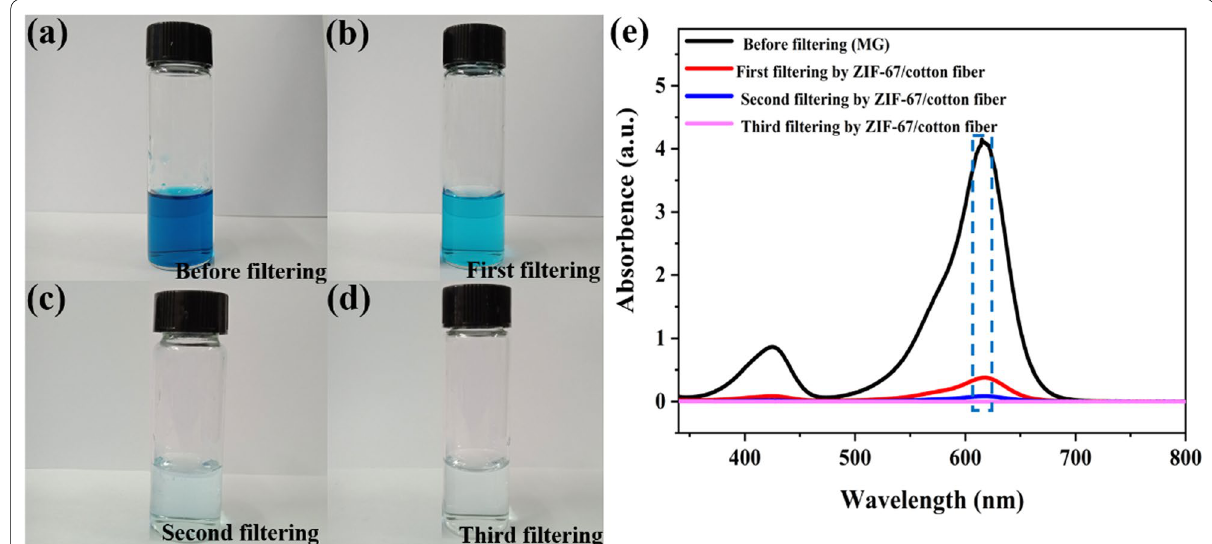
Fig. 8 Optical images of the MG solution before ( a ), first ( b ), second ( c ) and third ( d ) filtering cycles after passing through the ZIF-67/cotton fibers packed filter; and UV–vis spectra showing the variation of the MG concentration during the dynamic filtering experiment ( e ) (adsorption conditions: initial dye concentration, 100 mg/L; volume of dye solution, 10